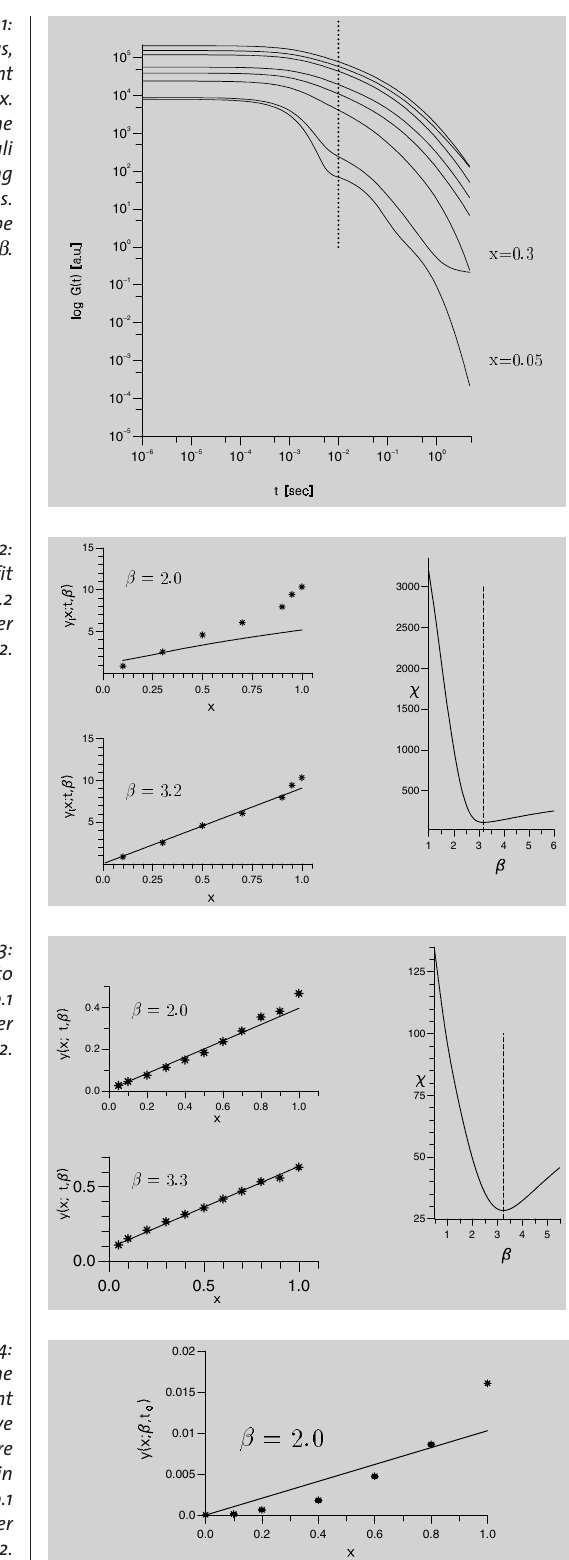
Figure 4: PS: β is determined to fit the data best. Three different mixture series of PS have been evaluated, hence there are three curves shown in the right figure. β =3.84 ± 0.1 describes the data better than β